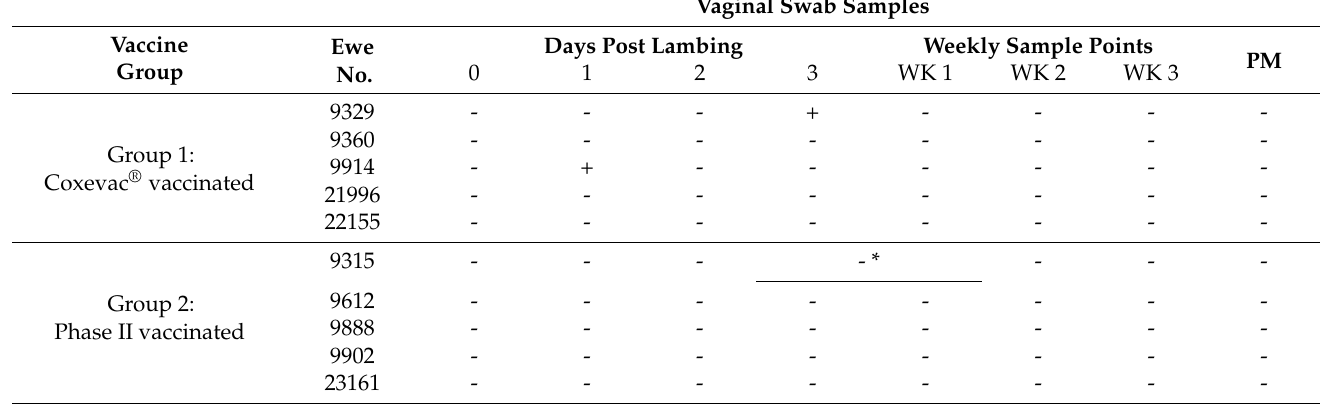
Table 3. Presence (+) or absence (-) of C. burnetii DNA in vaginal swab samples. Samples were collected on day of lambing (0) and then for three consecutive days (1, 2 and 3). Samples were then collected weekly for 3 weeks, with a final sample set collected immediately prior to post-mortem